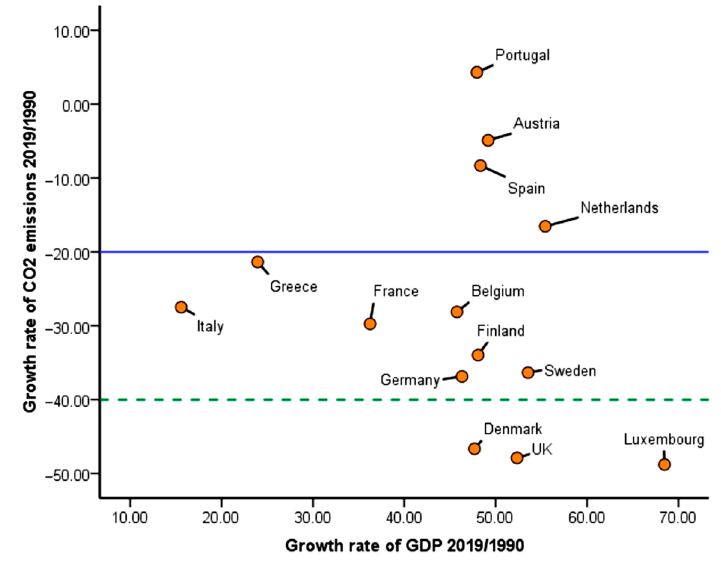
Figure 1. Growth rates of CO2 emissions per capita and GDP per capita in 2019 reported to 1990 levels in the EU15